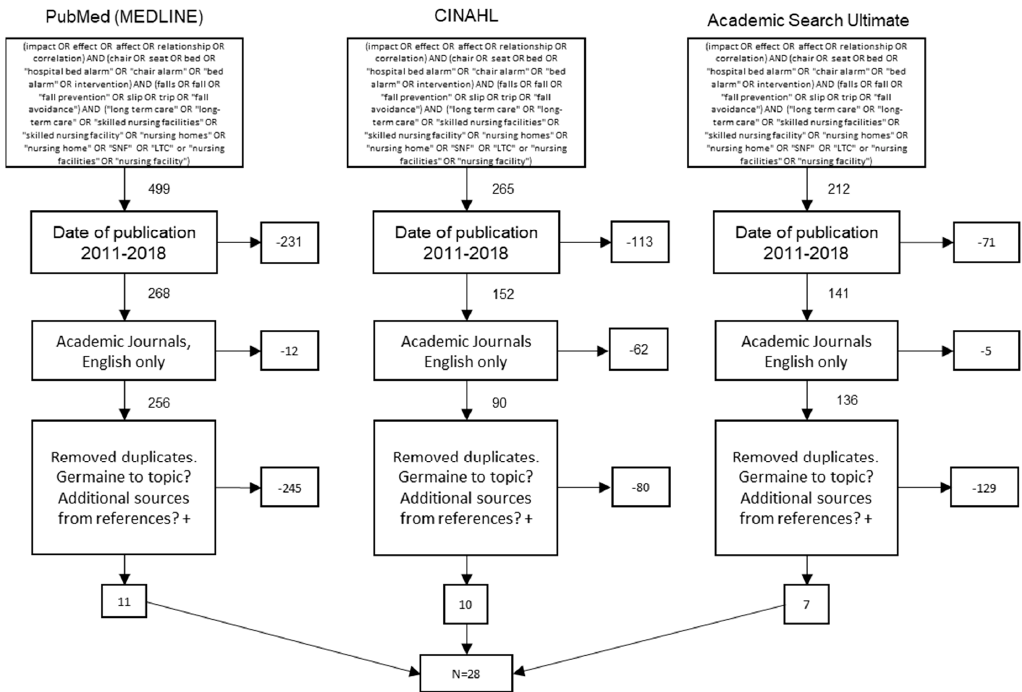
Figure 1. Preferred Reporting Items for Systematic Reviews flow diagram .